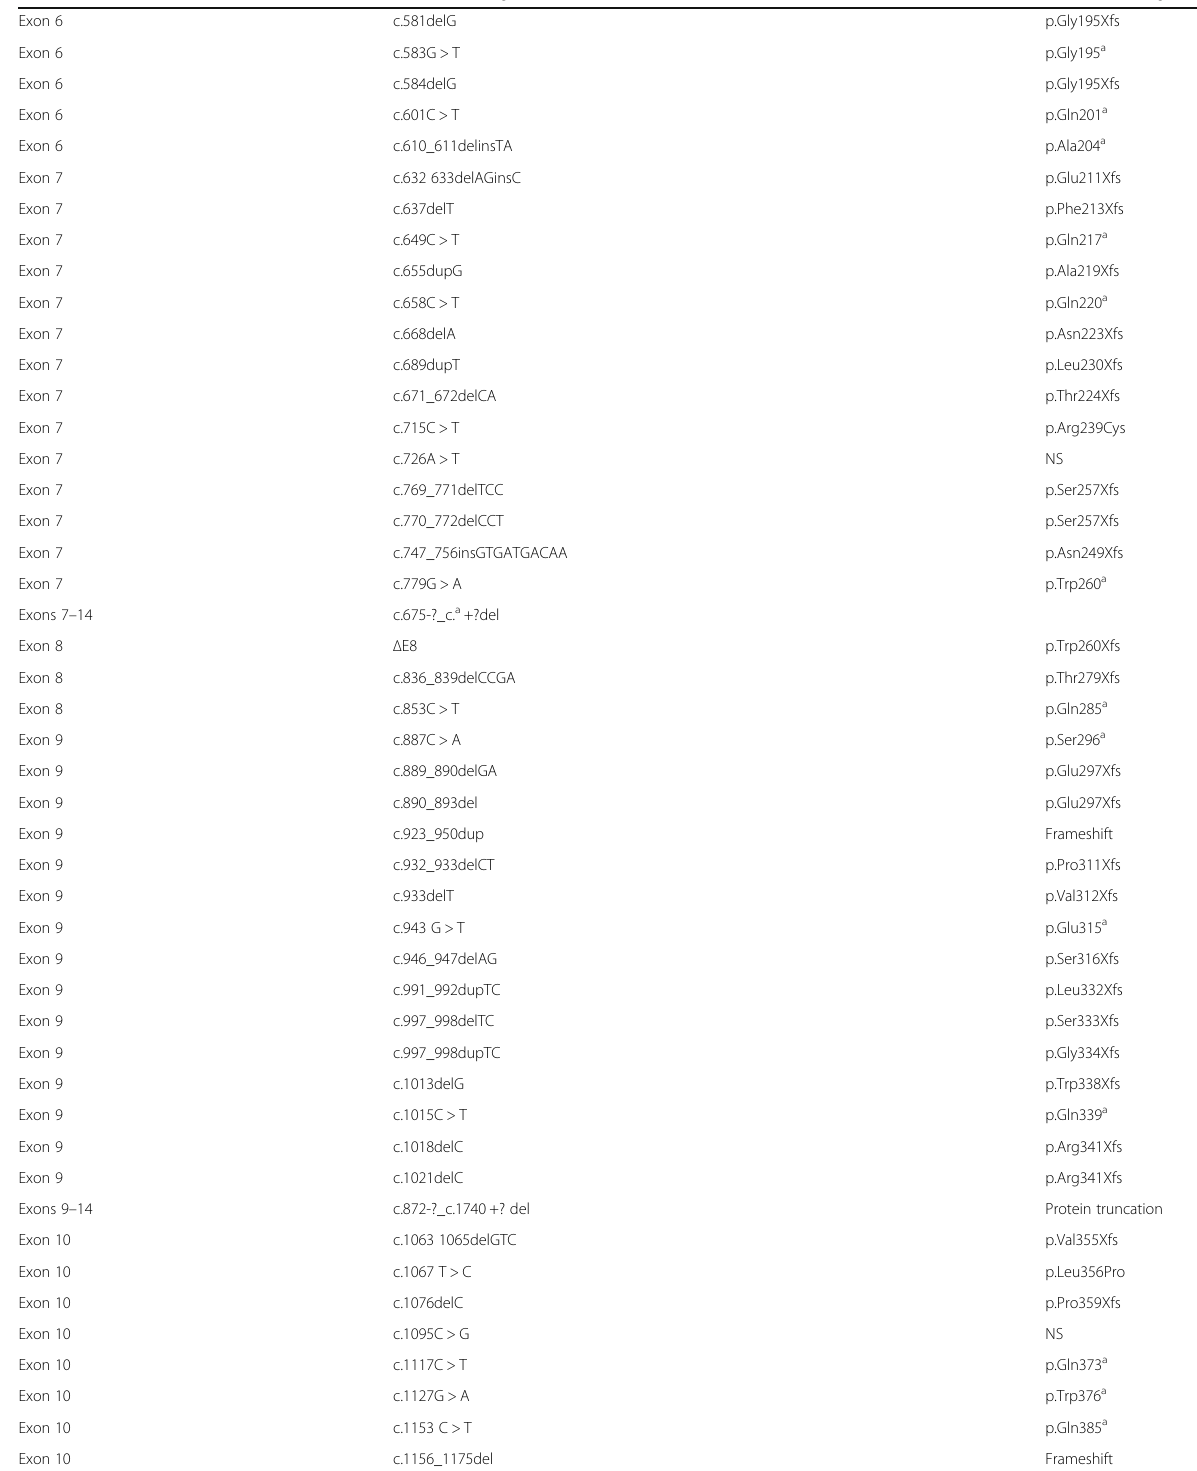
Table 1 Germline mutations in Birt-Hogg-Dubé syndrome